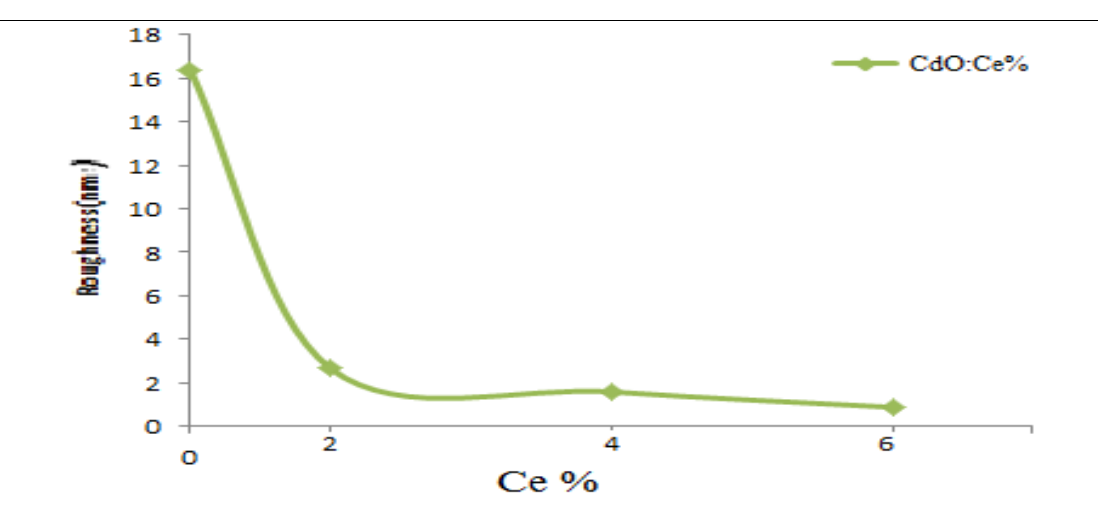
Fig. 7: Variation of roughness with Ce concentration for CdO prepared glass